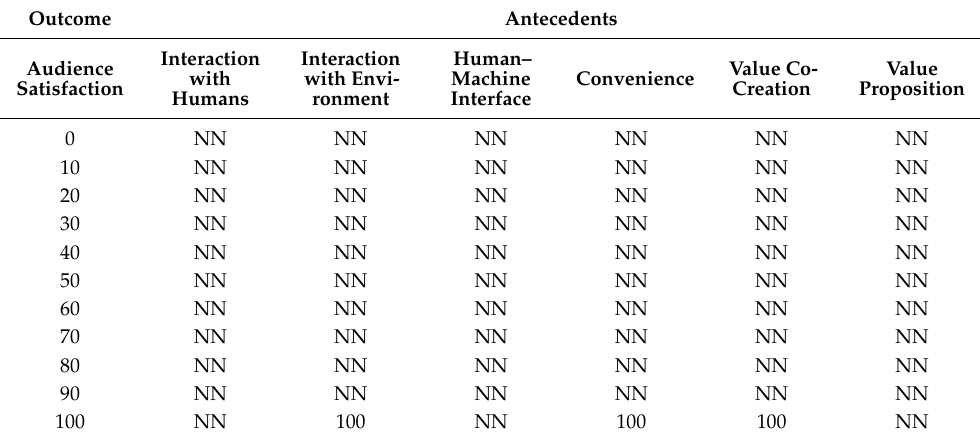
Table 7. The result of NCA bottleneck analysis